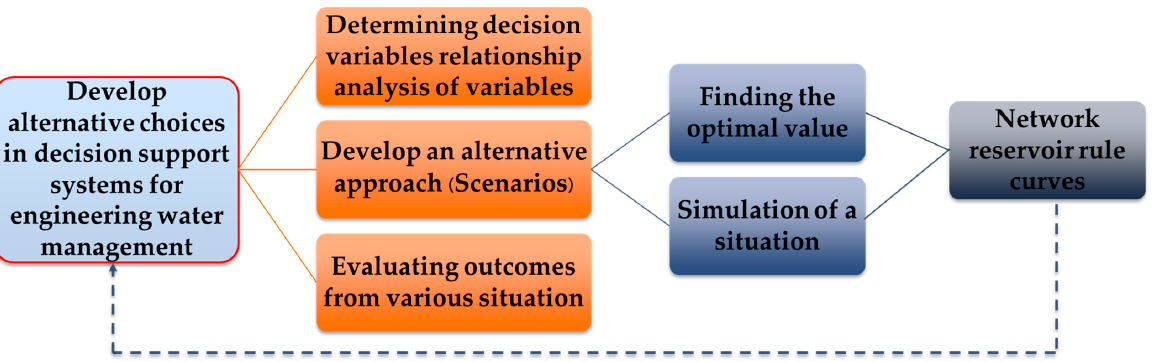
Figure 1. Methods of conducting research.